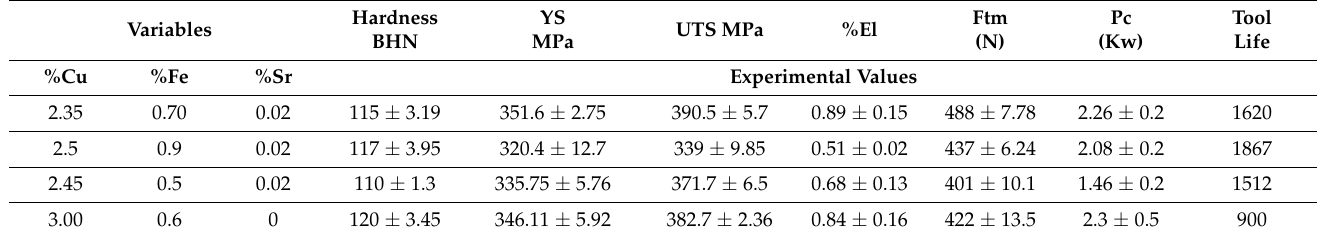
Table 7. Values of mechanical and machining properties obtained from random